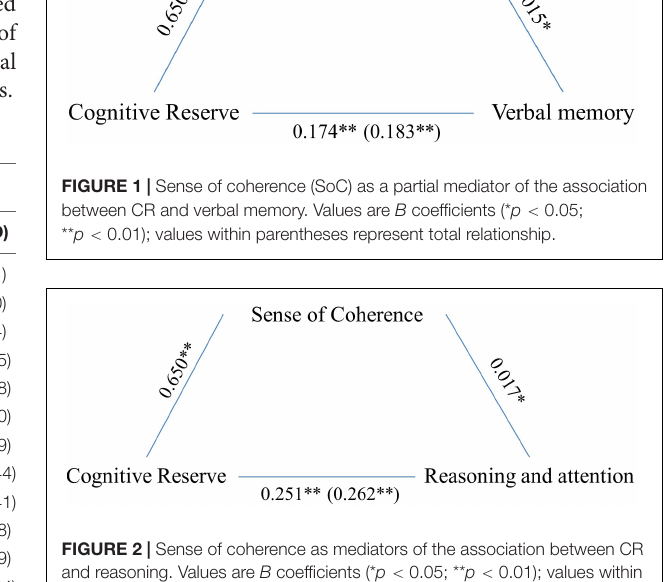
FIGURE 2 | Sense of coherence as mediators of the association between CR and reasoning. Values are B coefficients (* p < 0.05; ** p < 0.01); values within parentheses represent total